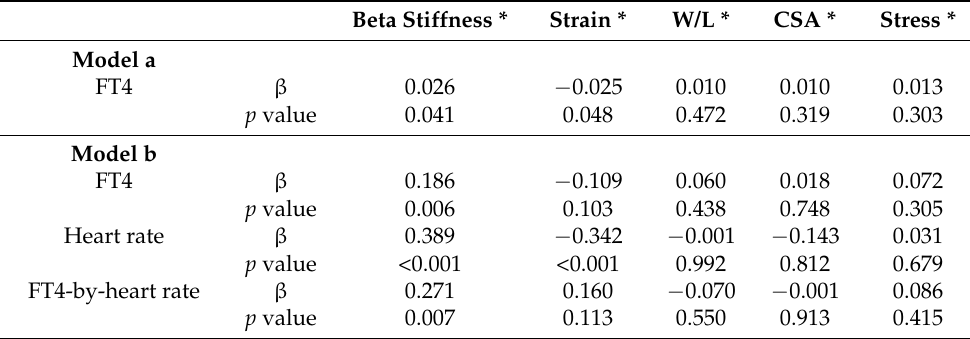
Table 3. Predictors of parameters of common carotid